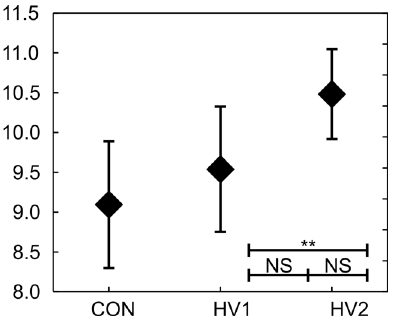
Fig.5 Peak range of motion of the pelvis (in deg) in the frontal plane